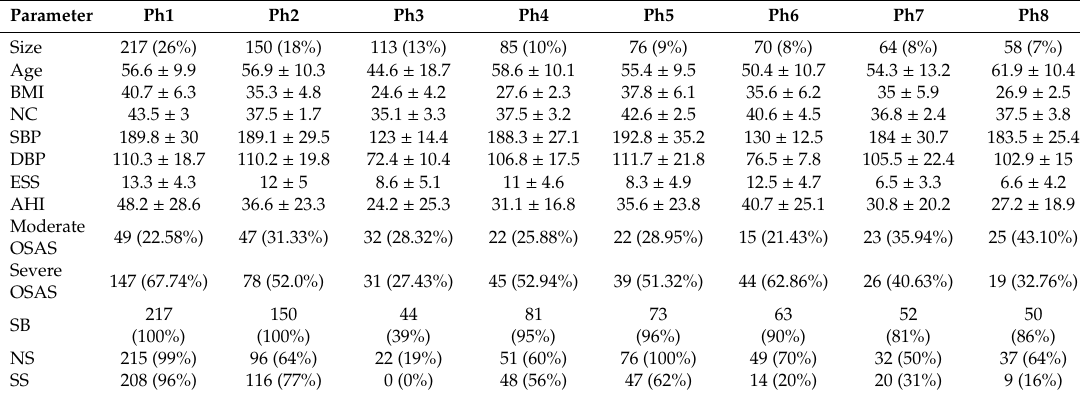
Table 3. Parameter distribution for phenotypes Ph1–Ph8 identified in the female cohort ( N = 848). Parameter Ph1